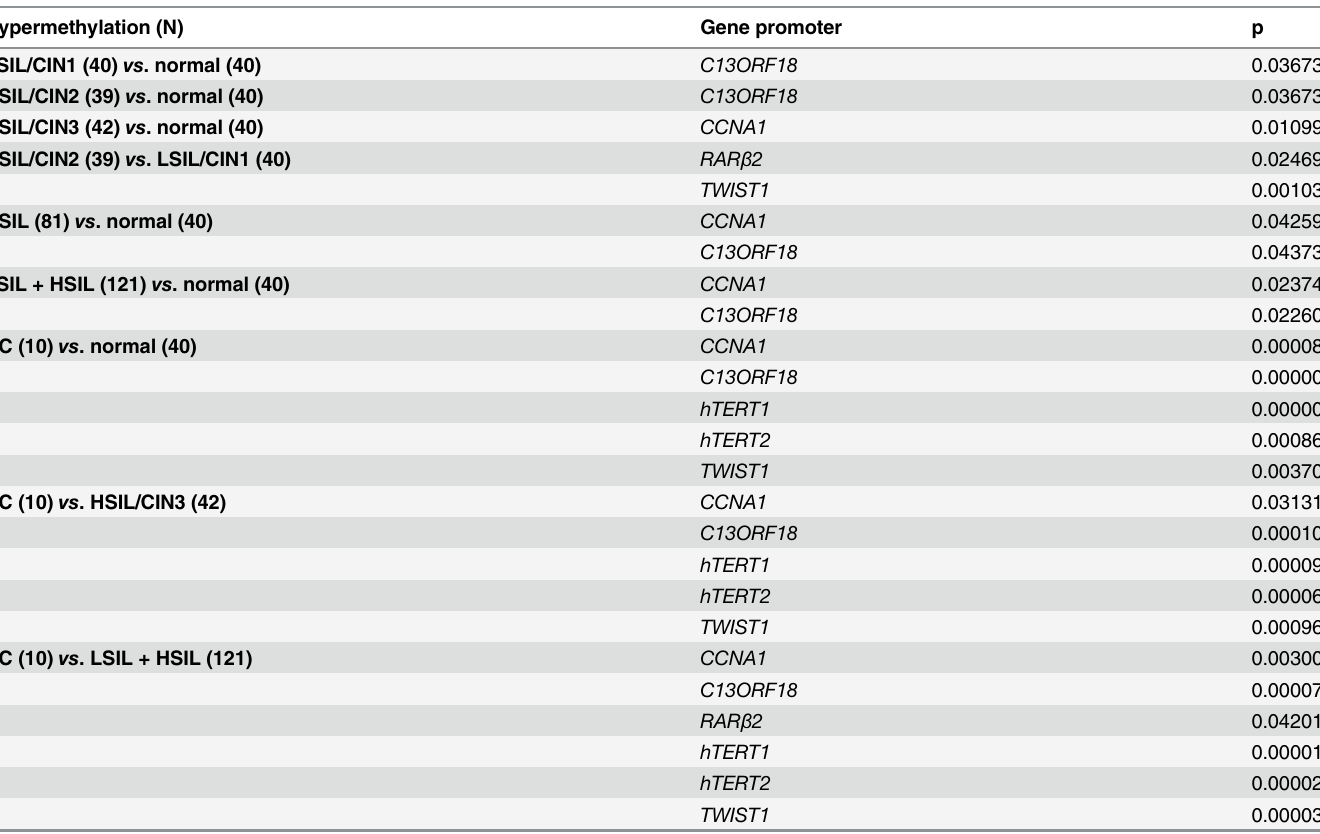
Table 2. Comparison of methylation status of gene promoter in cervical samples with different diagnosis — only statistically significant (Fisher ’ s exact test) increased methylation changes are